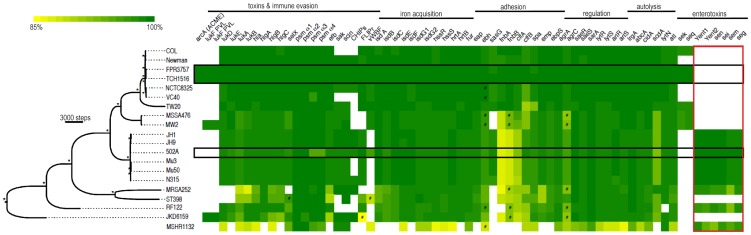
Whole genome phylogeny and heat map of gene content.The phylogenetic tree was constructed using whole genome alignment of gene coding regions for the strains pictured using the maximum parsimony (MP) optimality criterion (32,097 parsimony informative characters). Branch lengths are proportional to the number of nucleotide changes inferred for each branch. * denotes branches with 100% bootstrap support. The MP tree length was 74,526 steps (rescaled consistency index = 0.658). The staphylococcal genome MSH1132 was used as an outgroup. The heat map shows percent nucleotide identity over the entire sequence length based on BLAST comparison to each representative gene from the S. aureus TCH1516 genome as a query sequence. The area boxed in red shows comparisons using S. aureus 502A genes as queries. A cutoff of >84% nucleotide identity was used to determine presence of each gene. # denotes BLAST alignments of less than 95% of the sequence gene length. USA300 strains (FPR3757 and TCH1516) and 502A are highlighted in black boxes.